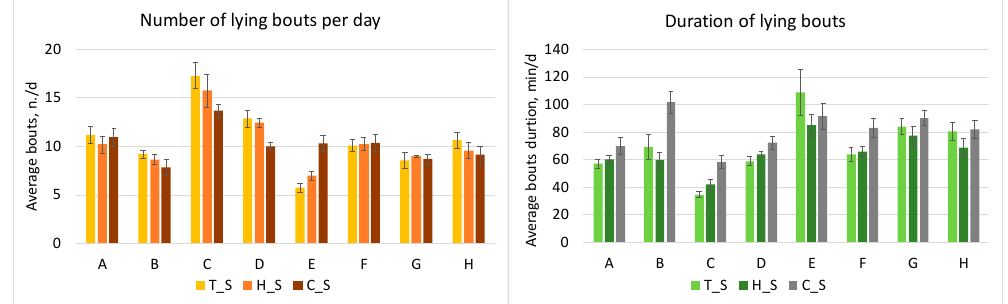
Figure 5. Average number of lying bouts per day (left figure) and duration of lying bouts (right figure) for the eight farms (A to H) in the three measurement periods (thermoneutral = T_S, hot = H_S and cold = C_S). Vertical bars express the standard deviation.